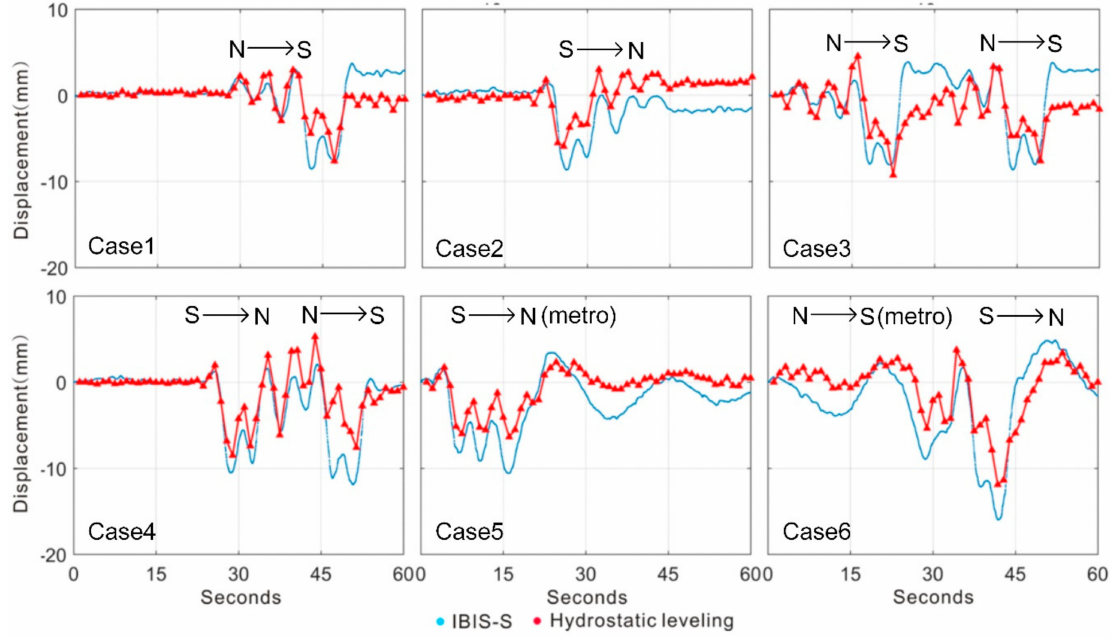
Figure 9. Vertical displacement time histories in the middle of 192-m span monitored by IBIS-S (blue lines) and the hydrostatic leveling system (red